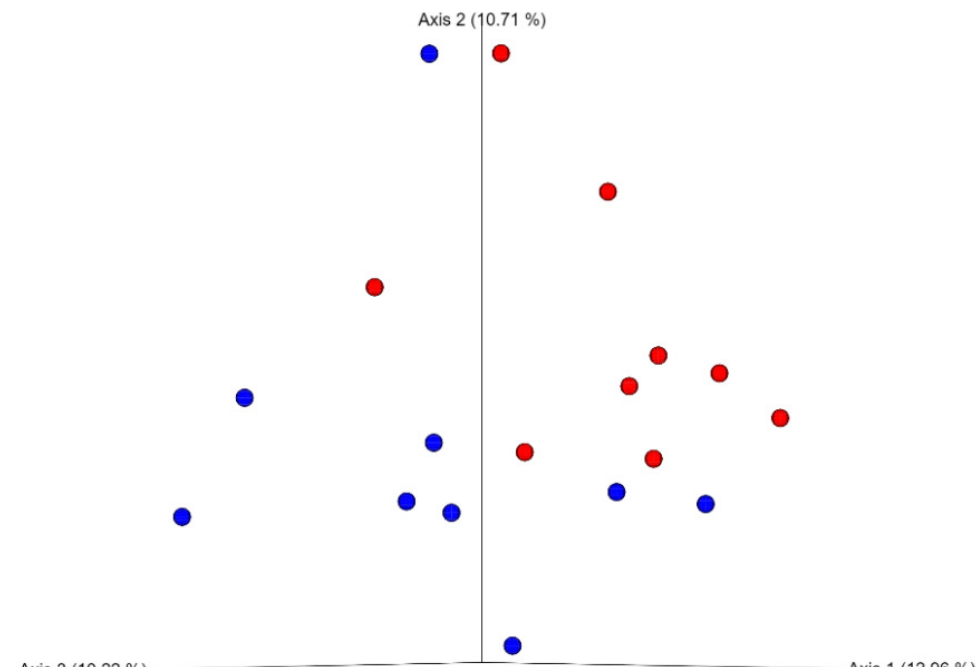
Figure 1. Principle coordinated analysis (PCoA) of the cecal microbiota of broilers at 21 days of age fed with or without inclusion of an enzymatic blend. Each point represents one sample (nine samples/treatment and a pool of cecal content from six birds/sample). Blue represents the samples from birds fed diets without enzyme supplementation, and red with enzyme supplementation.